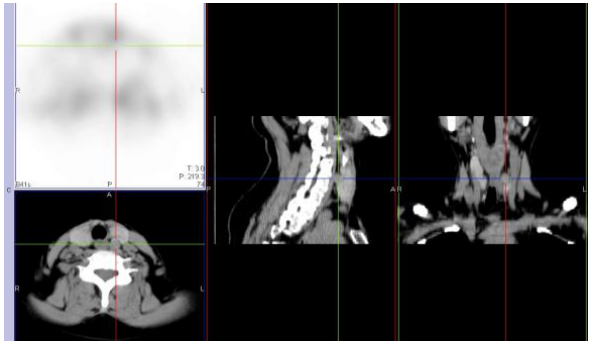
Fig. 1 US image of parathyroid gland hyperplastic nodules in the upper rear medium of left lobe of the parathyroid gland